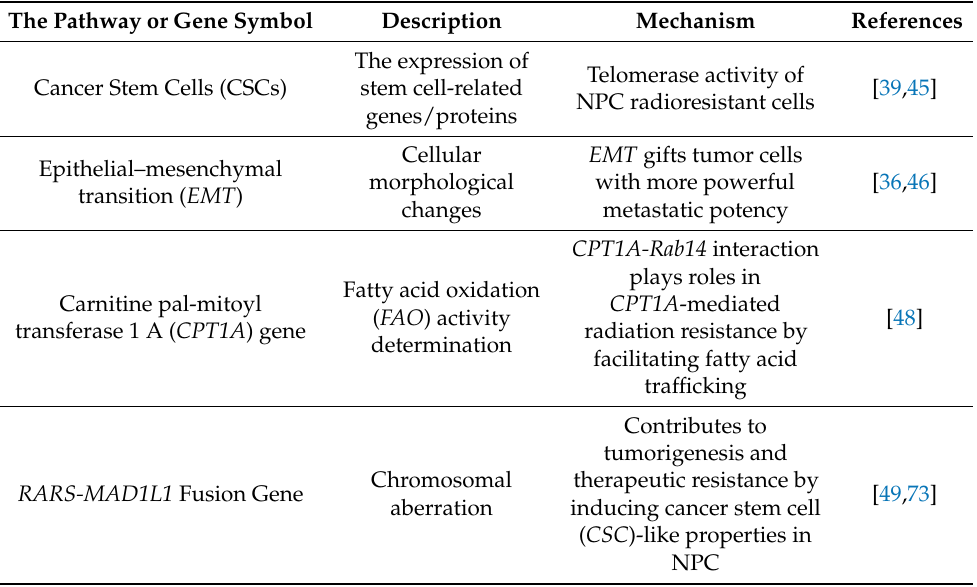
Table 1. Description profile of radioresistance mechanisms and their cellular pathway in NPC. The Pathway or Gene